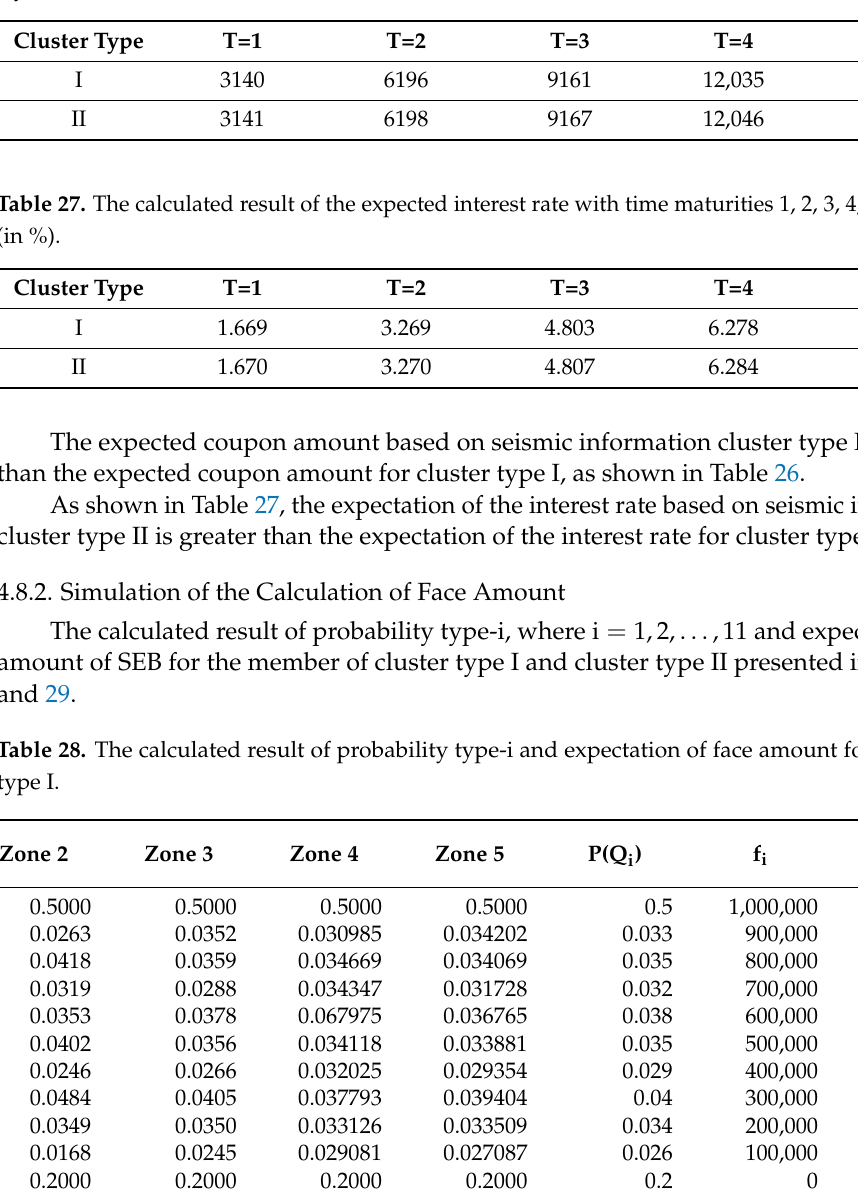
Table 26. The calculated result of expectation coupon amount with time maturities 1, 2, 3, 4, and 5 years (IDR).